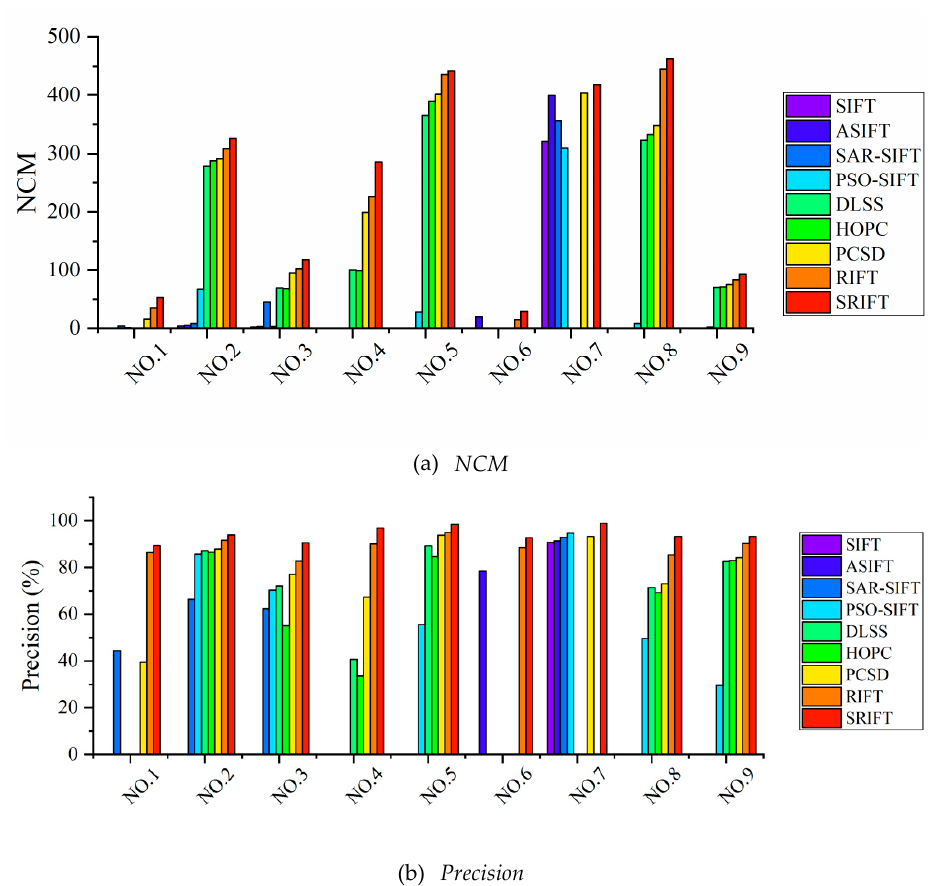
Figure 10. Multimodal remote sensing image registration display.